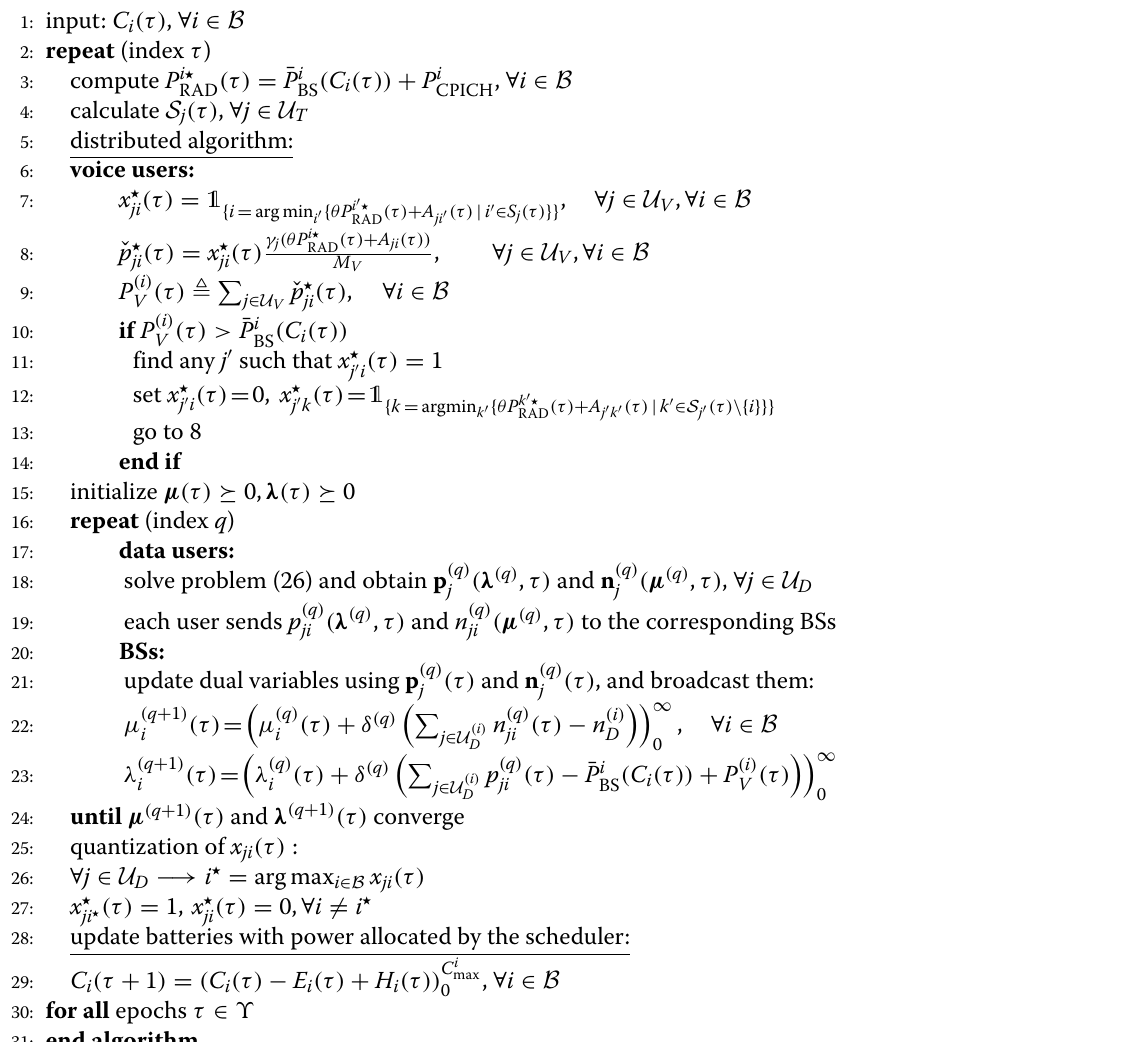
Algorithm 2 User association strategy based on the distributed